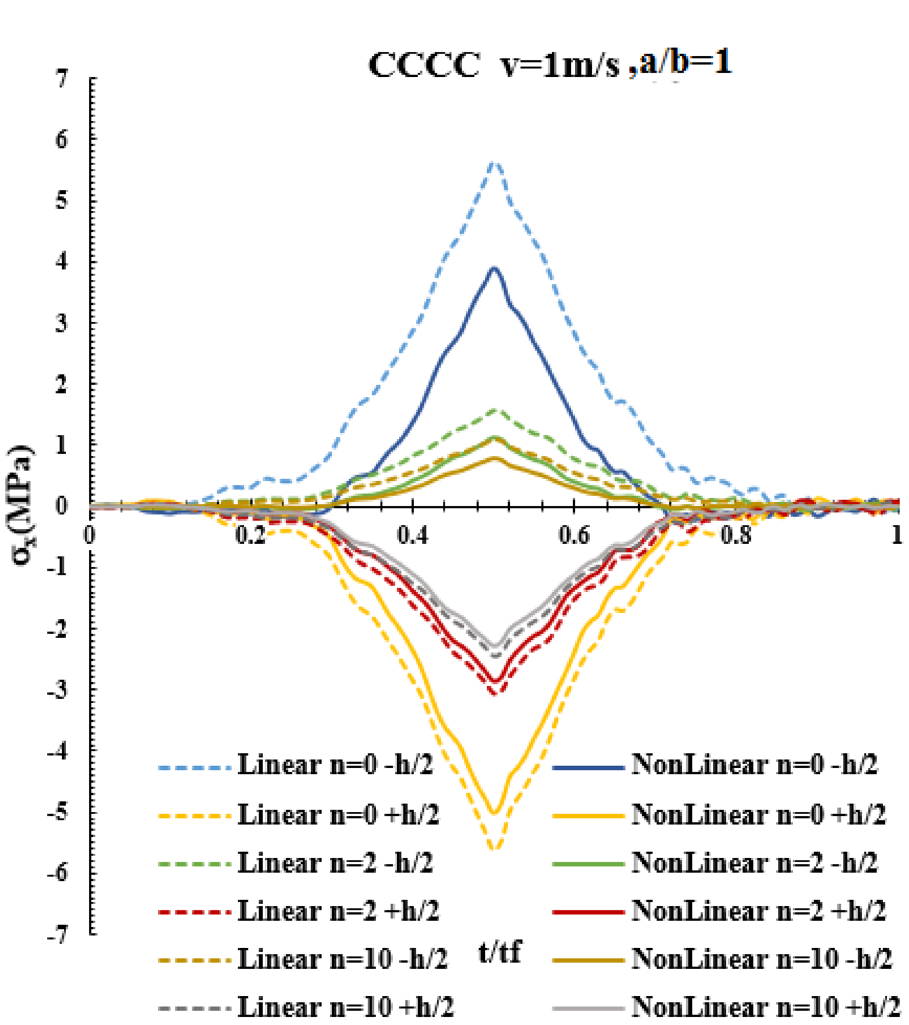
Fig. 18 The effect of material gradient index on transient dis- tribution of 𝜎 xx for center-point of the plate (CCCC, v = 1